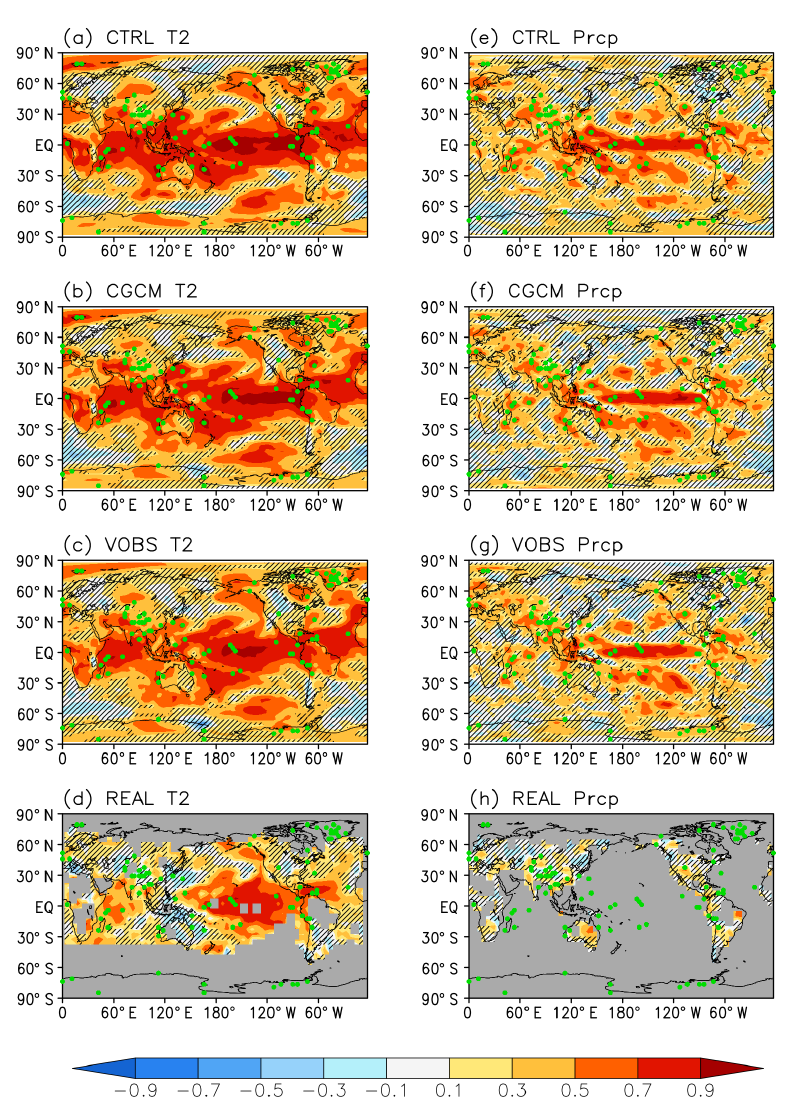
Figure 5. Temporal correlation between the analysis and the truth for (a–d) temperature and (e–h) precipitation, for each experiment. The green dots represent the location of the proxy sampling site. The hatched areas indicate where the correlation is not statistically significant ( p > 0 . 05).